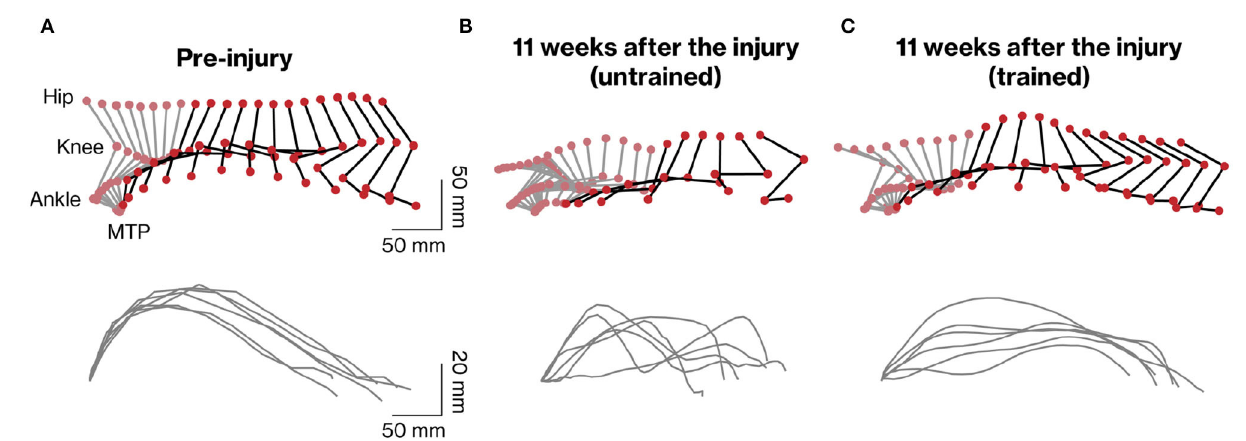
FIGURE 3 | Kinematic analysis of hindlimb movements assessed during quadrupedal walking. Representative stick diagrams of hindlimb movements in pre-injury (A) and 11 weeks after injury in untrained (B) and trained (C) groups are shown (upper panels). Gray and black sticks indicate stance and swing phases, respectively. The time between individual sticks is 35ms. Successive trajectories of the fifth metatarsal (MTP) are shown for the six consecutive steps in each group (lower